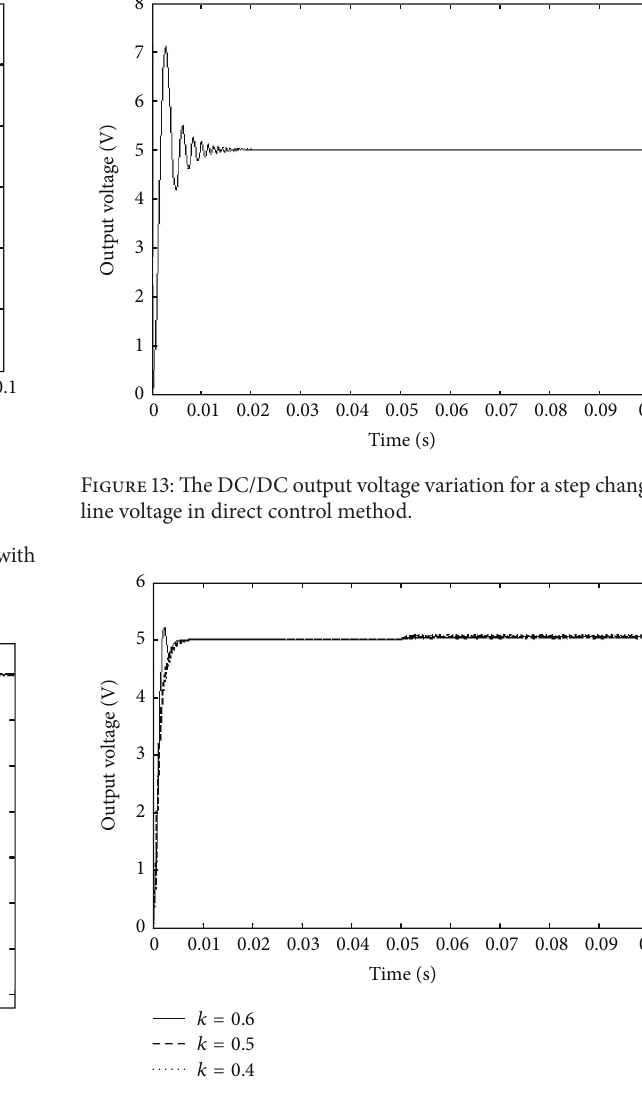
Figure 14: The DC/DC output voltage variation for a step change in Line voltage with respect to different values of 𝑘 in indirect control